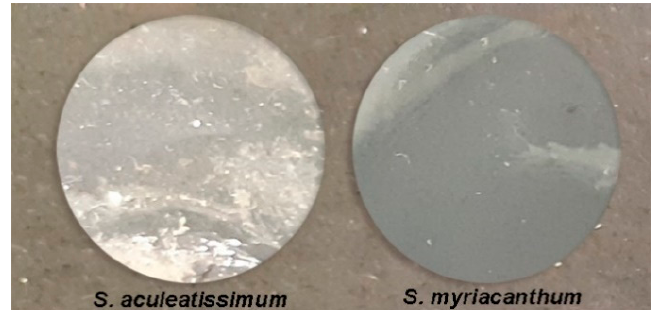
Figure 6. Photographs of the films prepared from hydrolyzed cutins.